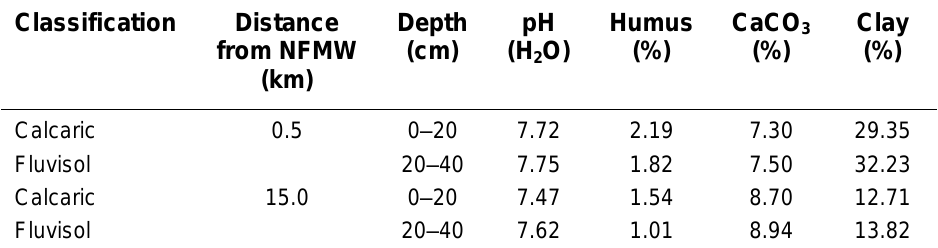
Soil Properties for Soil Sampled from the NFMW near